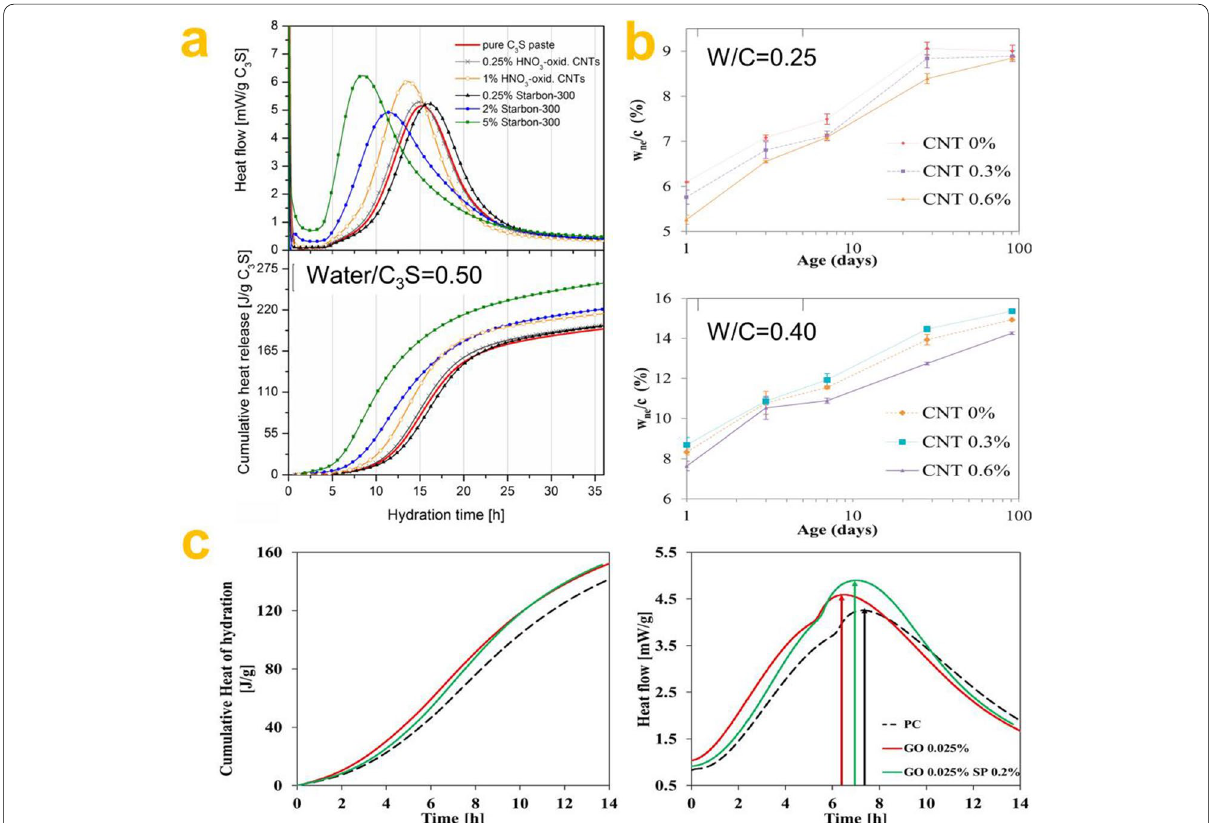
Fig. 6 a Isothermal calorimetry results for the C 3 S pastes [38]. (Copyright 2016 Wiley). b Hydration results were determined indirectly from the nonevaporated water [27]. (Copyright 2019 Elsevier). And ( c ) isothermal calorimeter results for cement paste [24]. (Copyright 2018 Elsevier). SP is a polycarboxylate